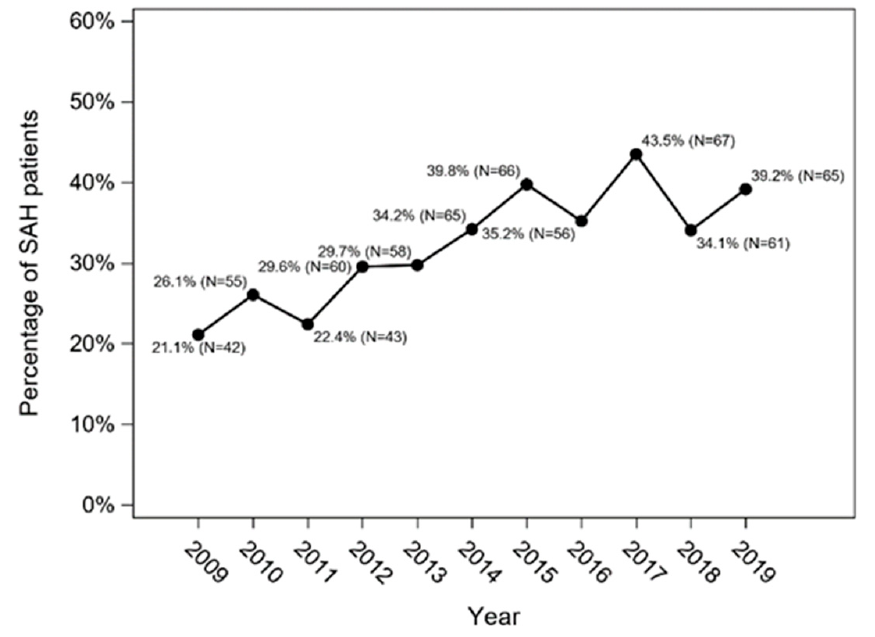
Figure 1. Percentage of SAH patients with previous history of hypertension in the Silesian Province between 2009 and 2019 (Cochran–Armitage trend test: p < 0.001). Table 3. The number of interventions in patients with SAH in the Silesian